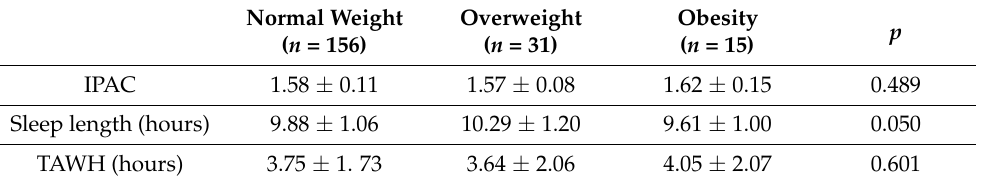
Table 3. Physical activity and sleep length of the schoolchildren in accordance with nutritional sta- tus.